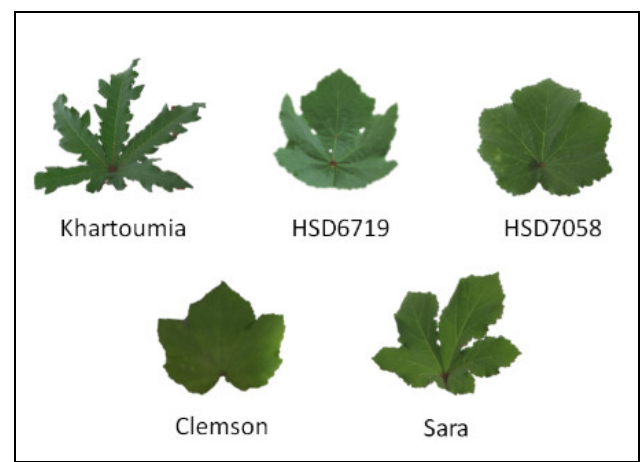
Figure 1. Leaf morphology of the five okra cultivars used in the experiment.